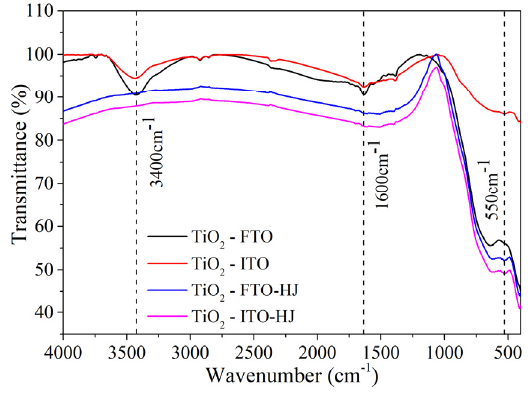
Figure 8. The FTIR spectrum of TiO 2 nanoarrays.